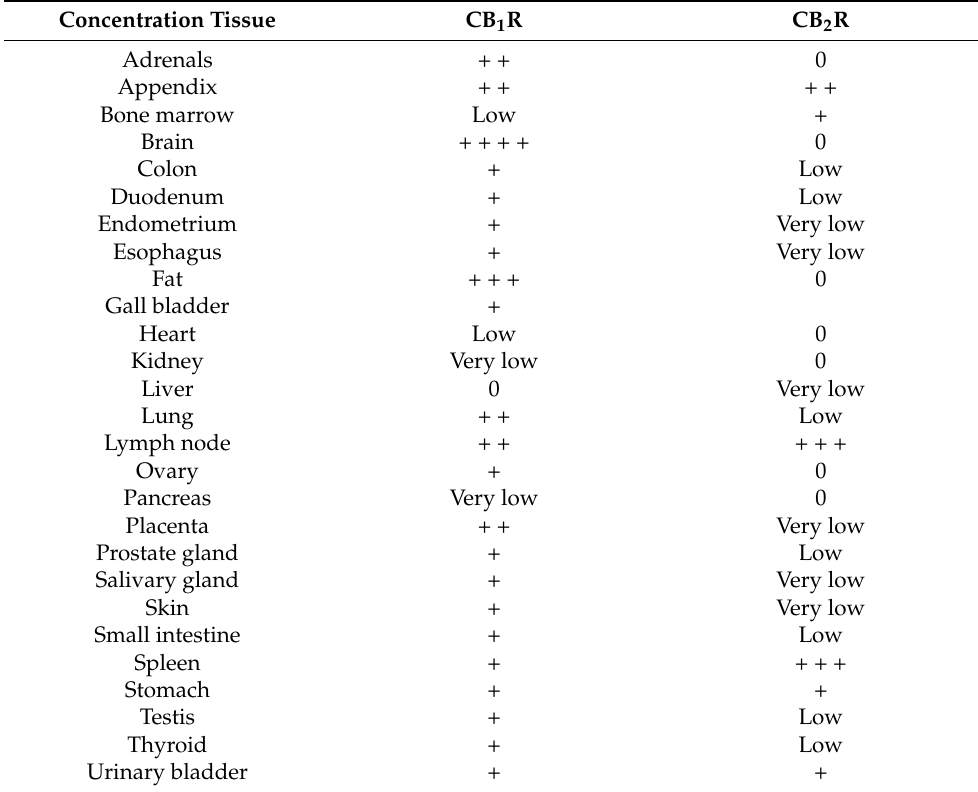
Table 1. Presence of CB 1 R and CB 2 R in human tissues [47–49]. Concentration